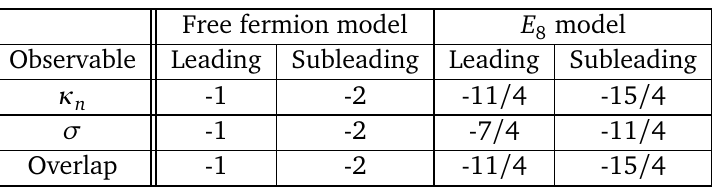
Table C.2: Extrapolation